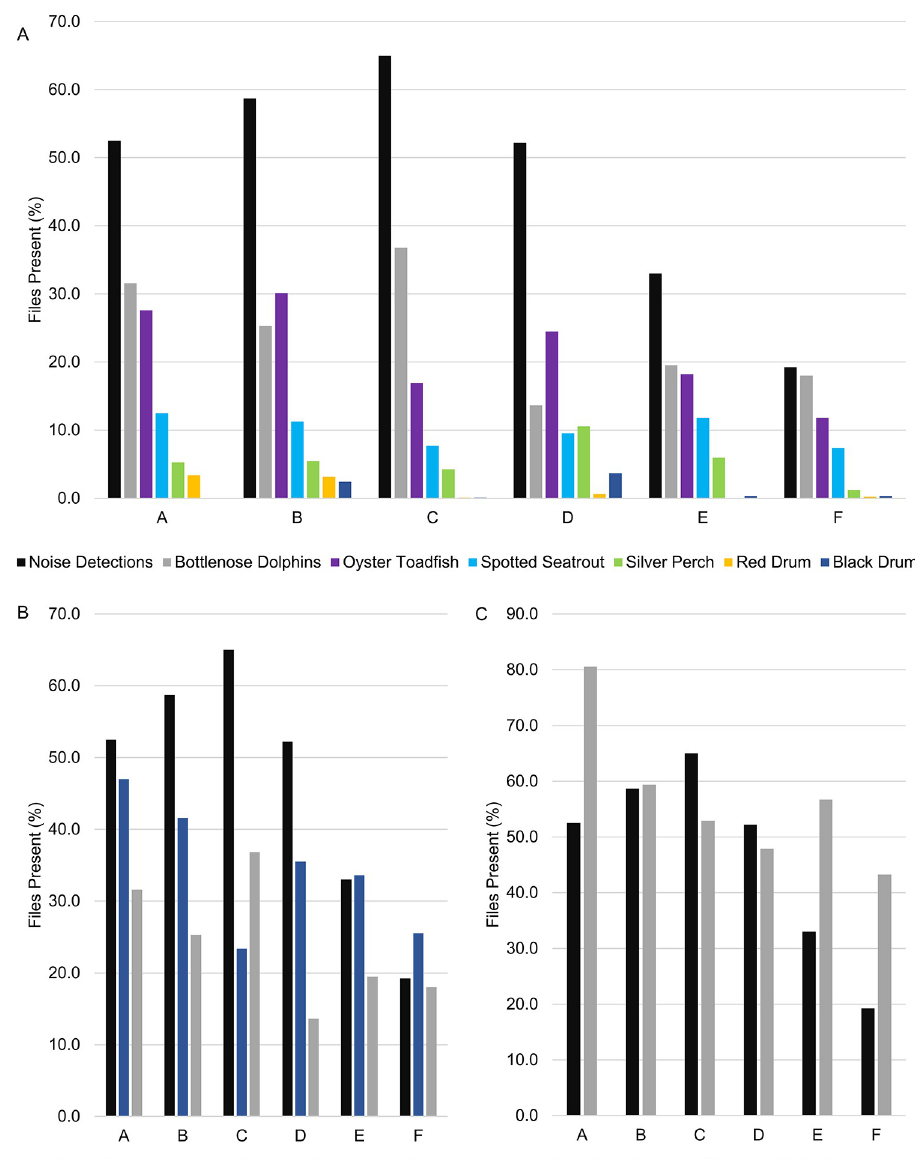
(any fish call or dolphin vocalization). A = Wando River, B = Drum Island, C = SC Aquarium, D = Fort Sumter, E = Ashley River, and F =